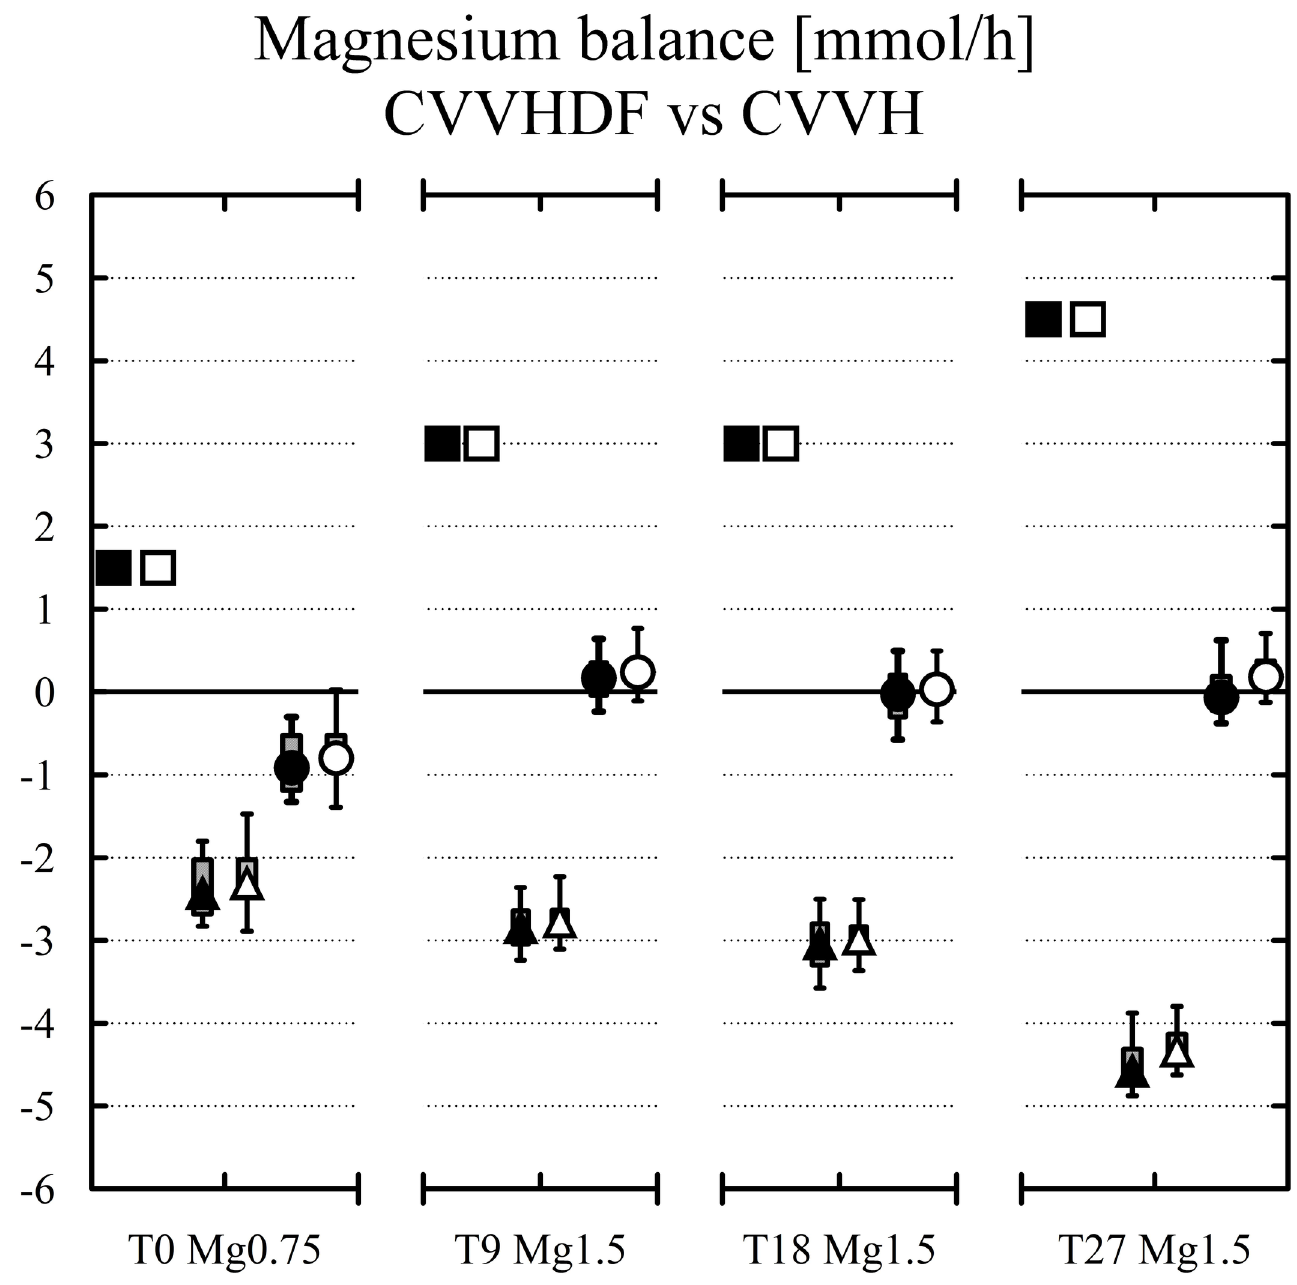
Fig 3. Magnesium inputs (black squares for CVVHDF and white squares for CVVH, both above zero) vs magnesium losses (black triangles for CVVHDF and white triangles for CVVH). The final balances at each study time (black and white circles) are in the middle. Median, IQR in boxes, Min-Max in